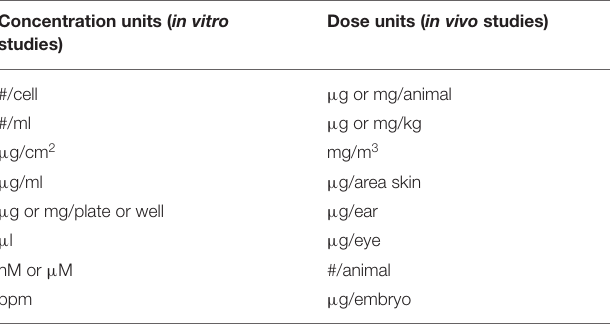
TABLE 3 | Dose and concentration units applied in the experiments of the 316 studies on amorphous silica